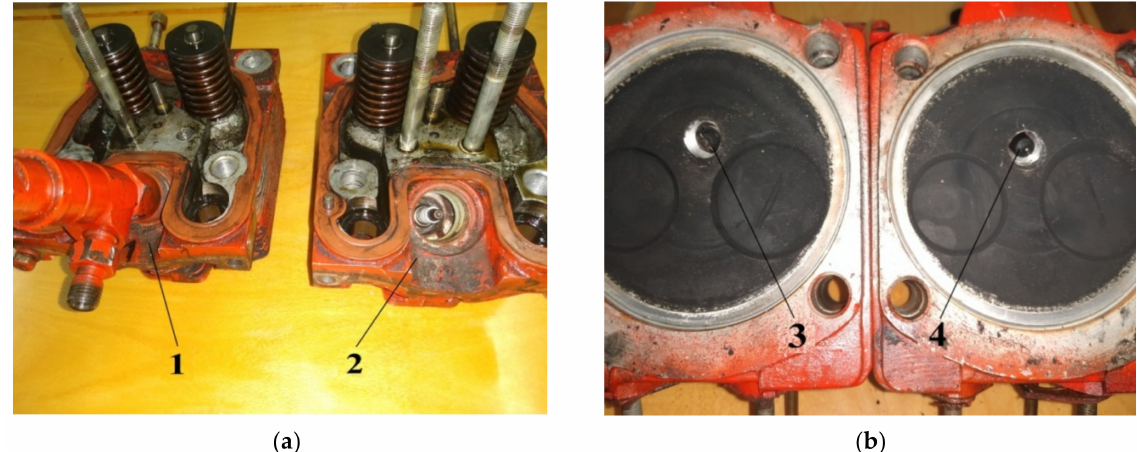
Figure 7. Conversion from diesel to gas fuel heads of the unit. View from the timing valves ( a ) and the combustion chamber ( b ) 1—the head of the block before re-equipment with the established diesel injector; 2—the head of the block after re-equipment with the dismantled injector and the established spark plug; 3—spark plug; 4—diesel